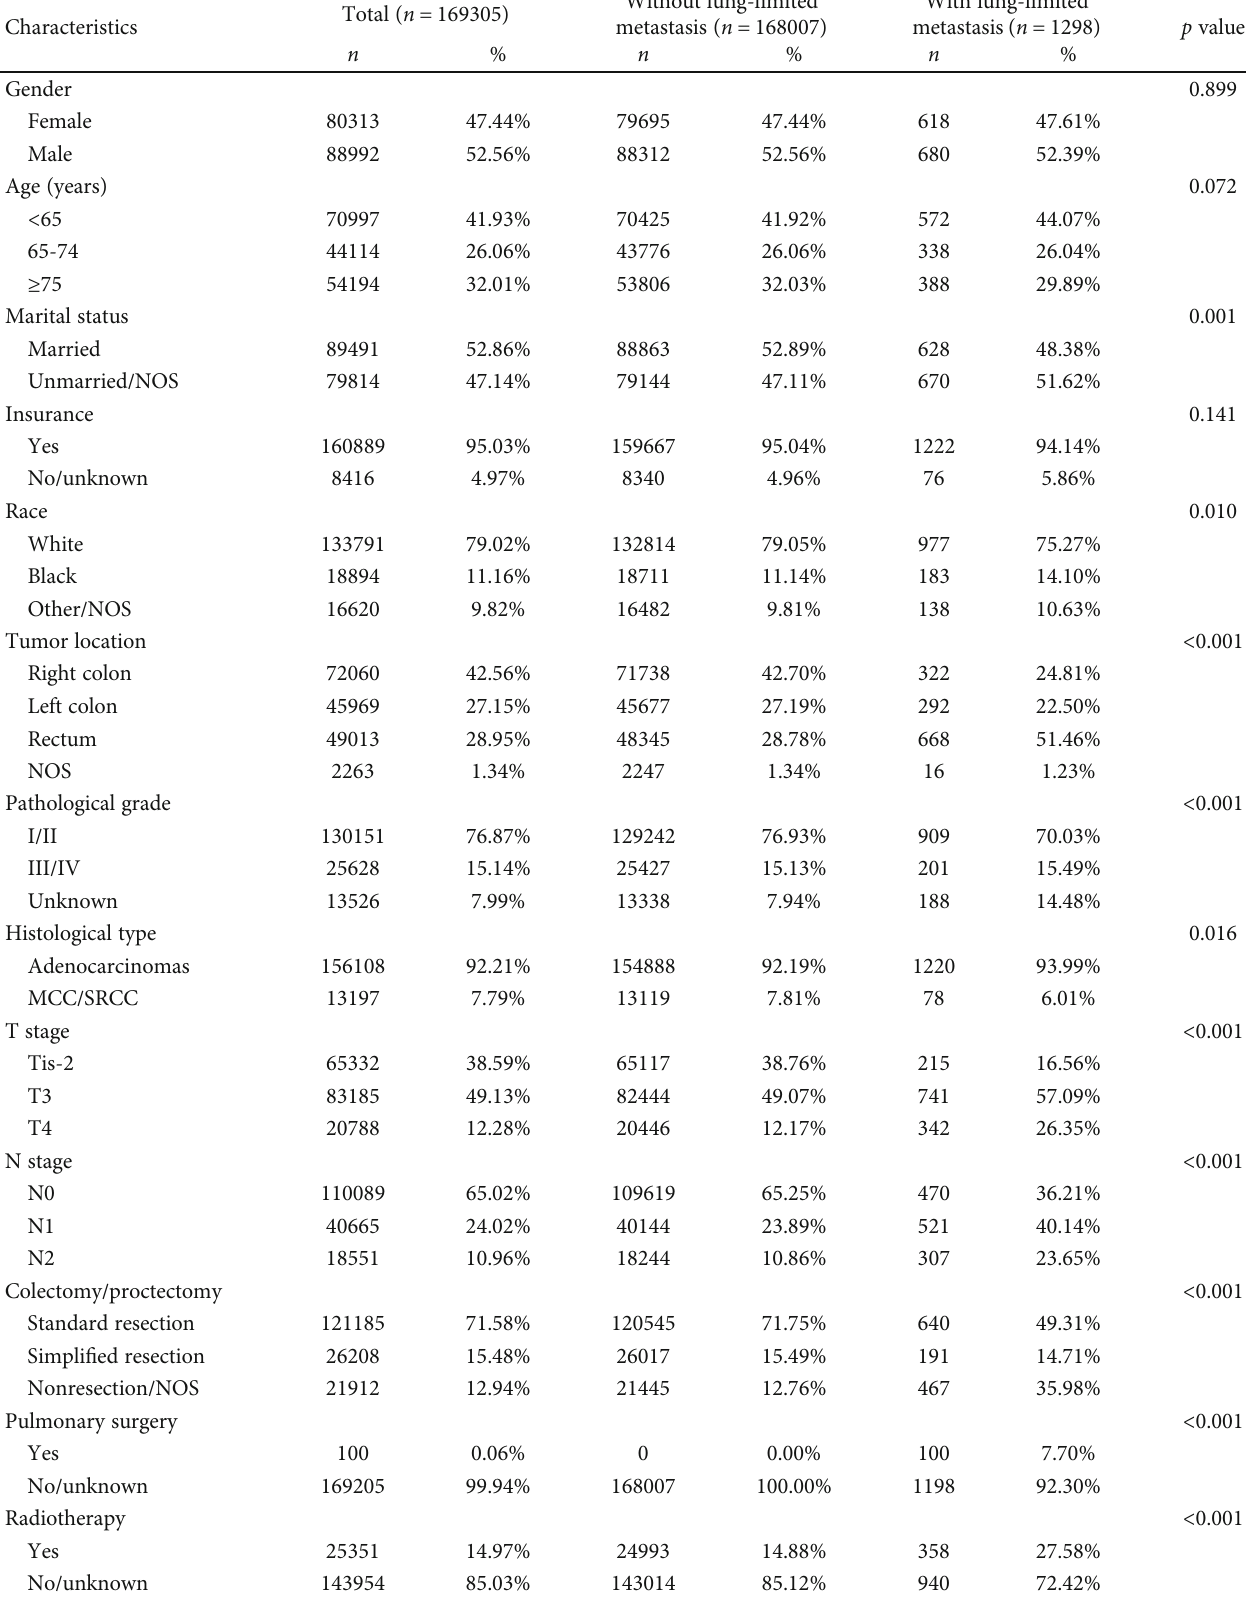
Table 1: The characteristics of CRC patients associated with lung-limited